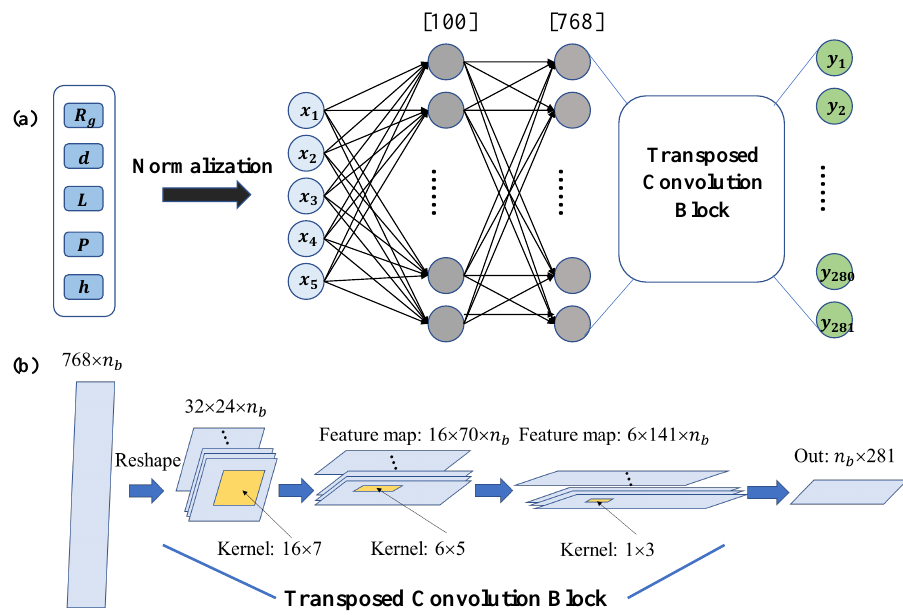
Figure 2. Illustration of forward prediction machine-learning network. ( a ) The five design parameters are normalized as a 5-dimension vector input for the machine-learning network. The output points correspond to 281 sample points of reflective spectrum in 6–20 GHz. The network consists of two fully connected layers and a transposed convolution block. ( b ) The working mechanism of transposed convolution block considering batch size in training process with three transposed convolution layers. Here, n b is the batch size. The kernel size for each layer and feature-map evolution are demonstrated. This block eventually turns information from the second fully connected layer into 281 dimensions’ output which can reproduce the reflective